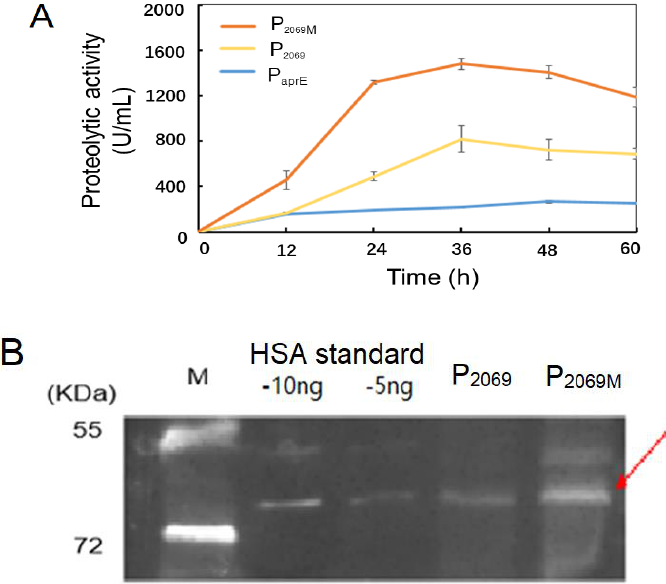
Figure 4. Evaluation of the mutation promoter P 2069M in driving expression of various heterologous genes. ( A ) Alkaline protease expression controlled by three promoters of P aprE , P 2069 and P 2069M over 60-h fermentation; ( B ) Expression of the recombinant human serum albumin (HSA) driven by promoters P 2069 and P 2069M was analyzed by the western blotting at 24 h. The arrow indicates the target protein HSA. M: Protein marker, the standard HSA loaded with 5 ng and 10 ng, respectively.